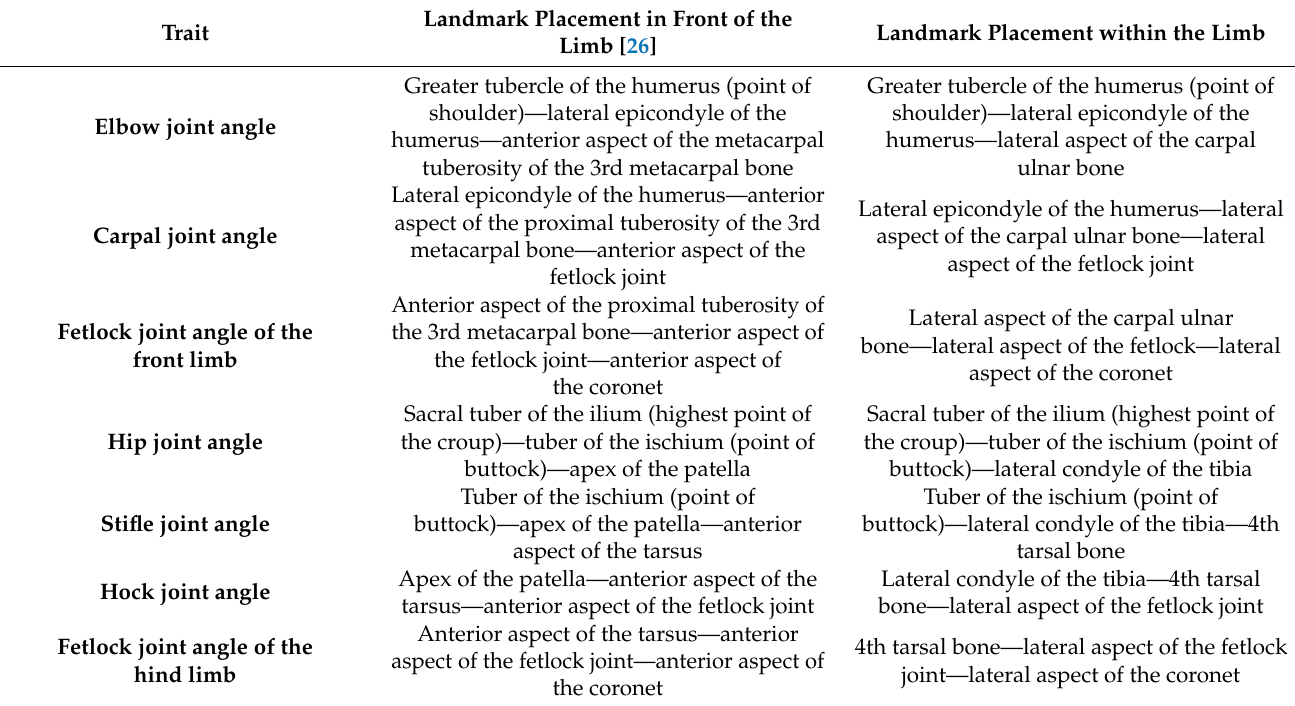
Table 1. Landmark placement determining the pairs of joint angles calculated from the horse shape space